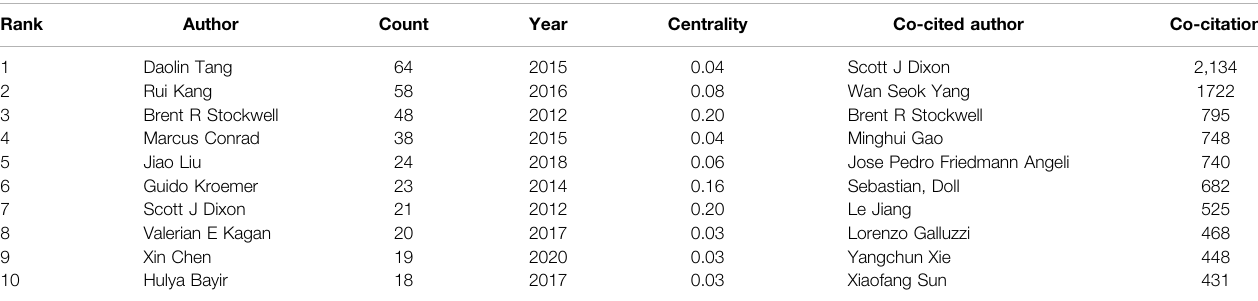
TABLE 4 | The top 10 authors and co-cited authors in the fi eld of ferroptosis in